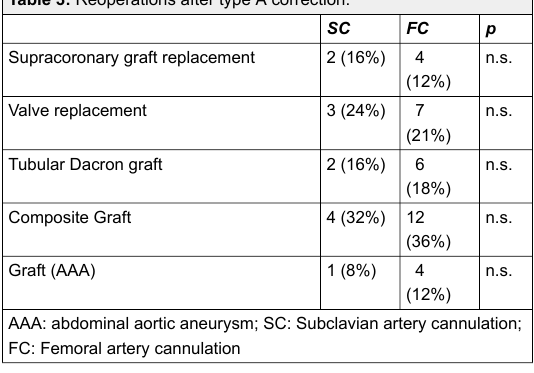
Table 3: Reoperations after type A correction.